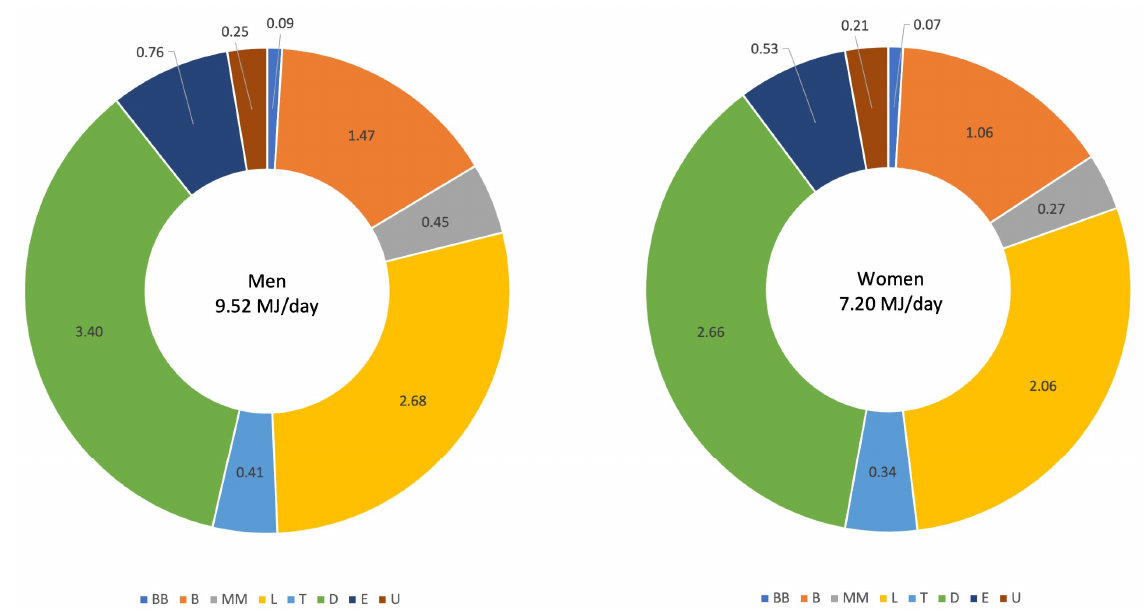
Figure 2. Mean reported energy intake distribution over the day (MJ/d). Data are unadjusted, grouped by sex. Abbreviations: BB, before breakfast; B, breakfast; MM, mid-morning; L, lunch; T, tea; D, dinner; E, evening; U, unknown.